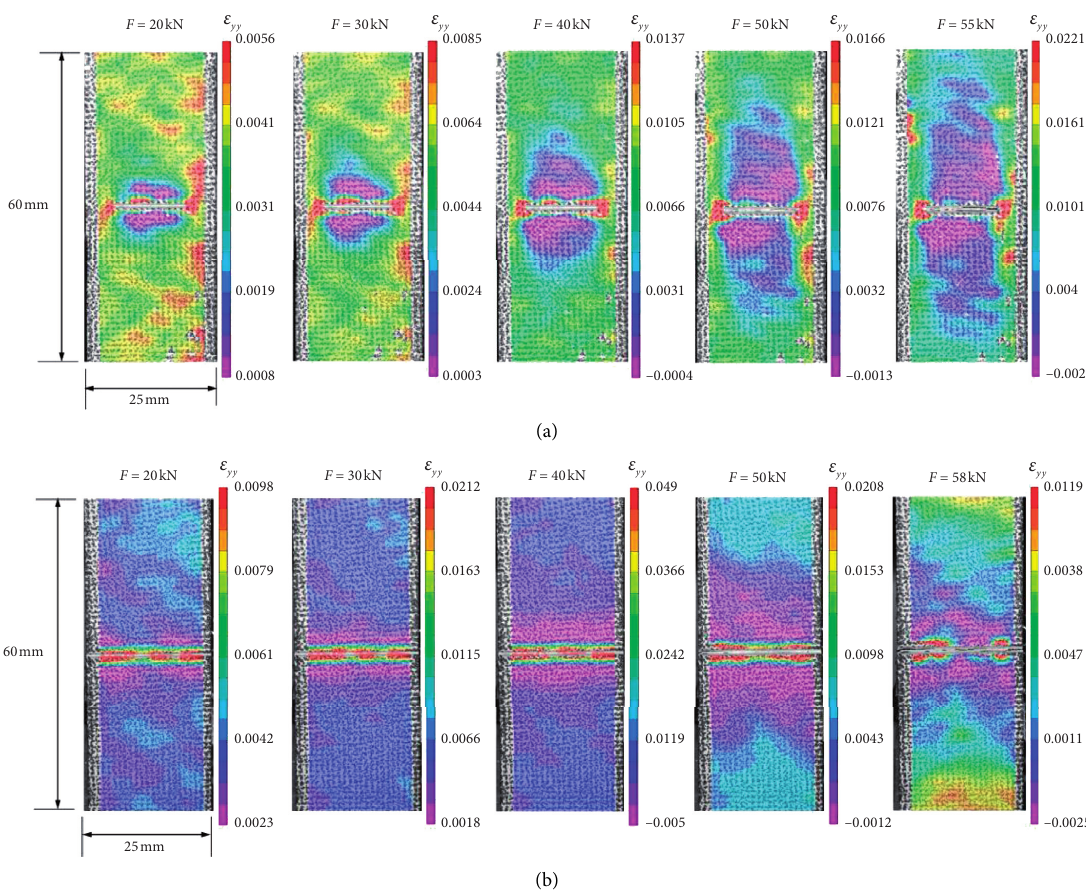
Figure 6: Strain fields ε yy obtained using the DIC technique during testing: (a) L